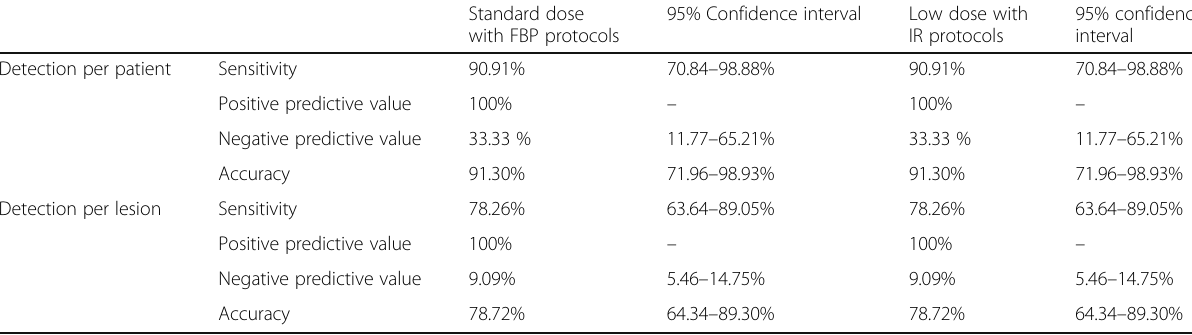
Table 4 Diagnostic performance per patient and per lesion in detection of bladder